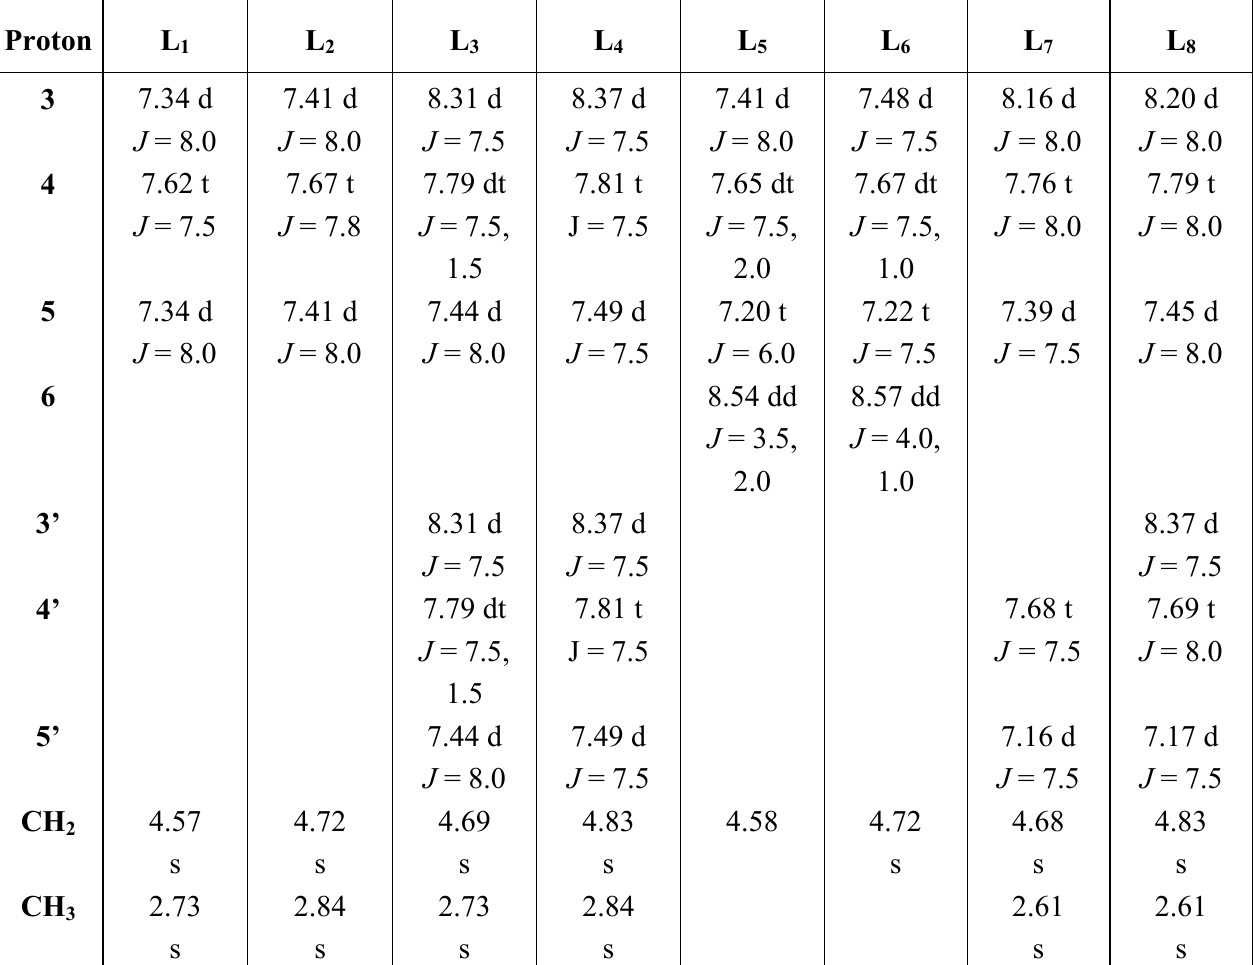
Table I . 1 H=NMR parameters of ligands L